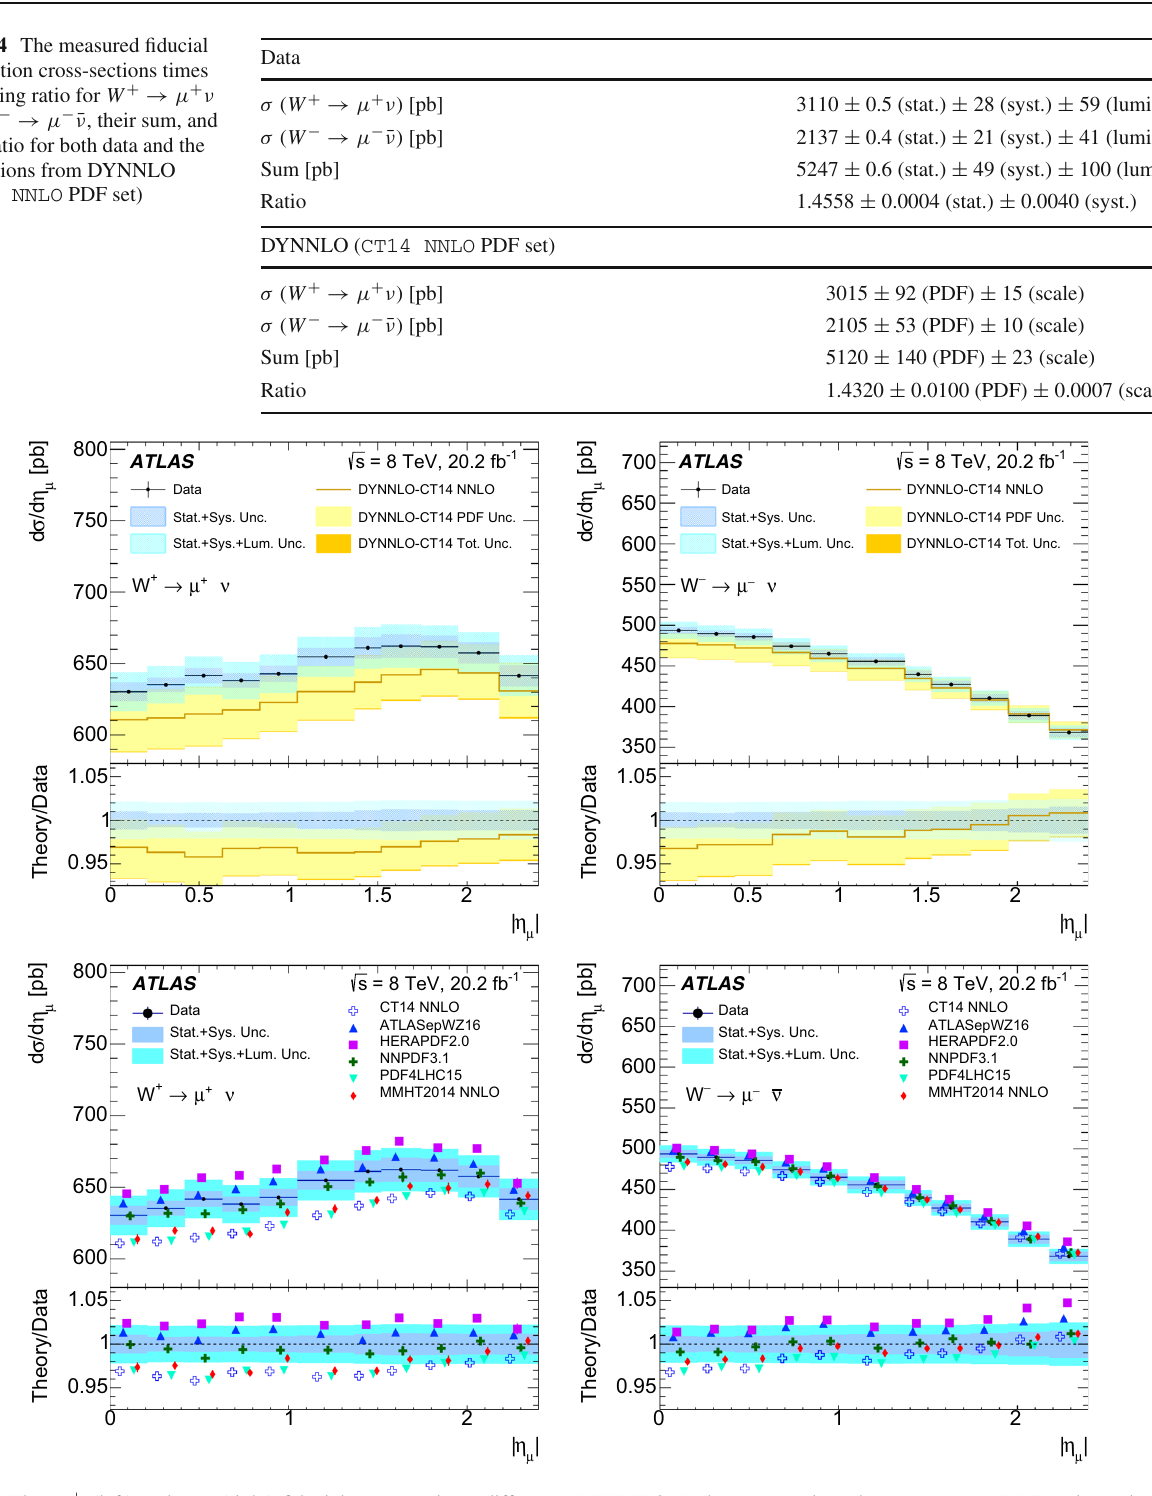
DYNNLO. In the top two plots, the CT14 NNLO PDF set is used, and DYNNLO is shown with its associated total theoretical uncertainty. In the bottom two plots, the data are compared with the central values of six different PDF sets described in the text. The statistical uncertainties of the DYNNLO predictions are indicated by error bars. The ratios of the data to the corresponding prediction are shown in the lower